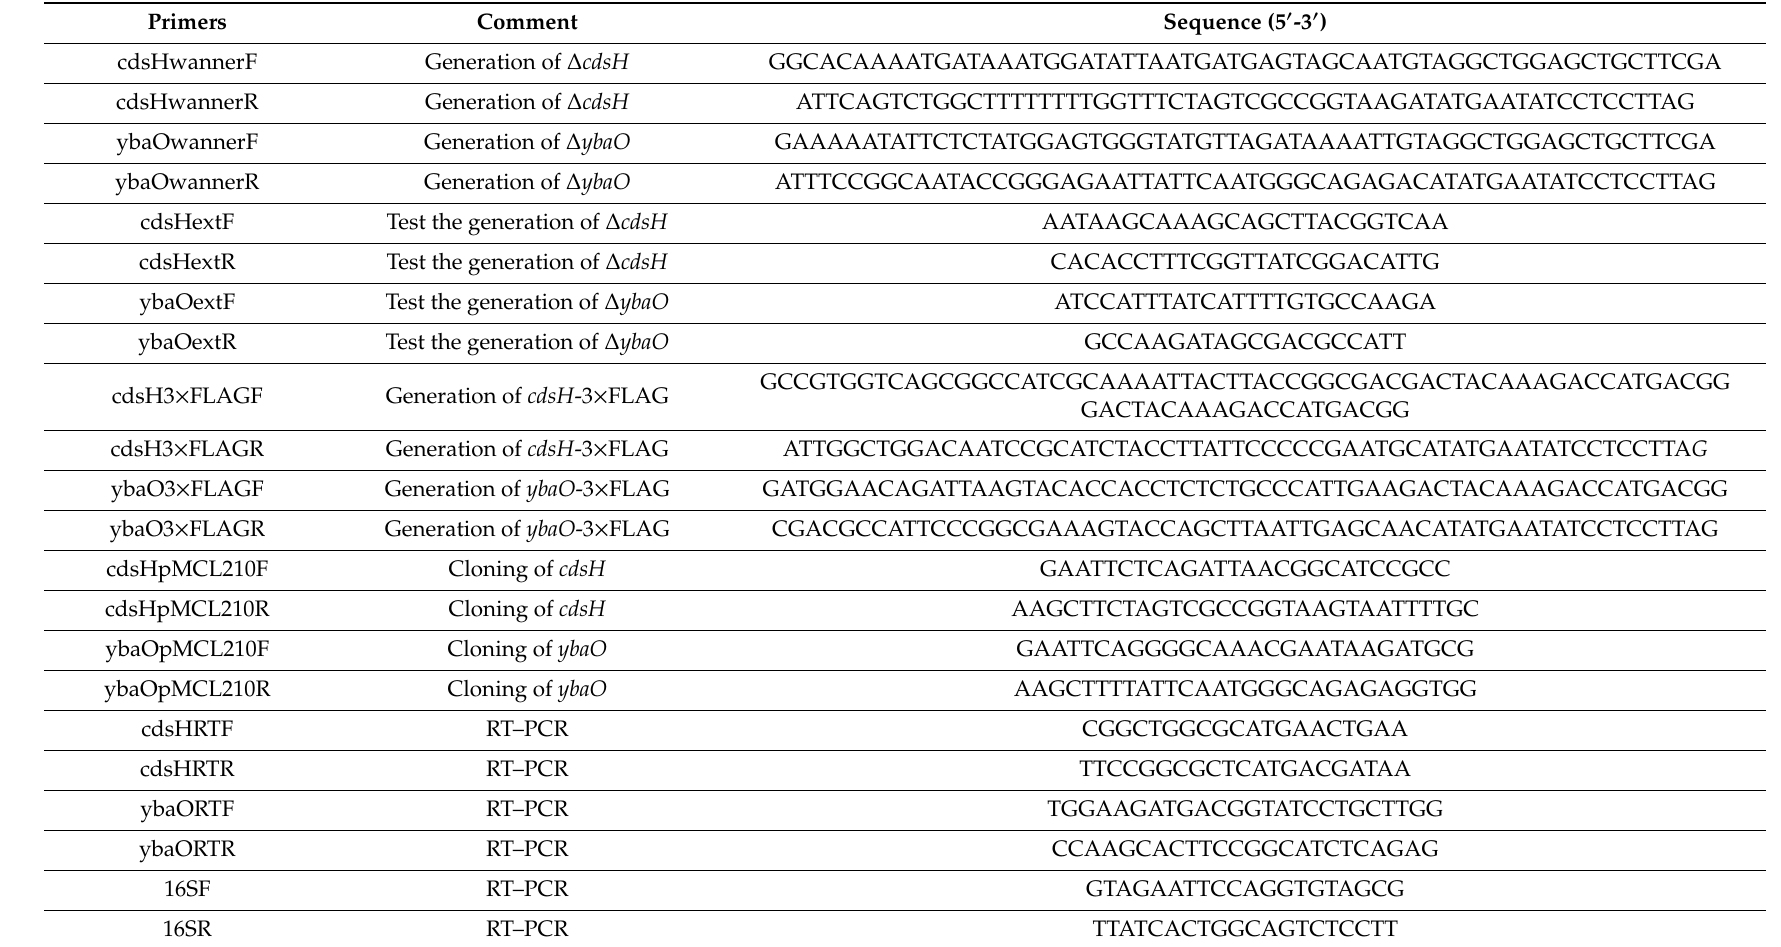
Table 1. Primers used in this